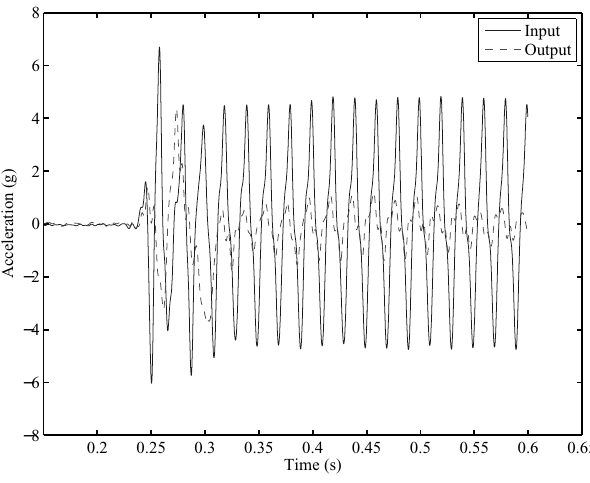
Fig. 8. Input acceleration and the transmitted acceleration to the pile